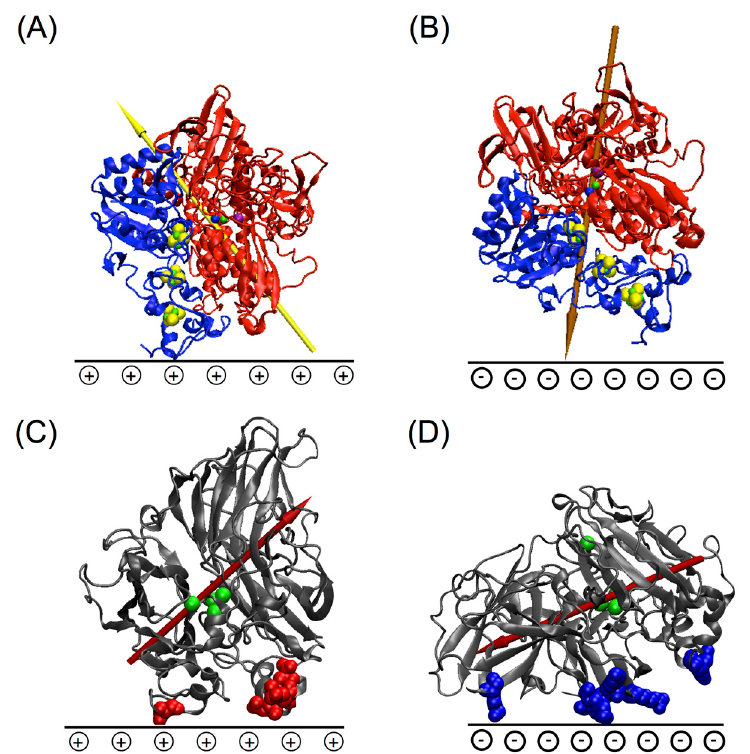
Figure 10. The fluctuating dipole moment of the [NiFe]-Hase from A. aeolicus enables it to adsorb efficiently on both positively and negatively charged surfaces (panels ( A ) and ( B ), respectively) [172]. On the other hand, the strong dipole moment in the LAC from T. versicolor leads to different enzyme orientations on positively and negatively charged surfaces (panels ( C ) and ( D ), respectively) [173]. Negatively charged residues interacting with the surface are shown as red van der Waals spheres in panel ( C ), while positively charged residues are shown in blue in panel ( D ).